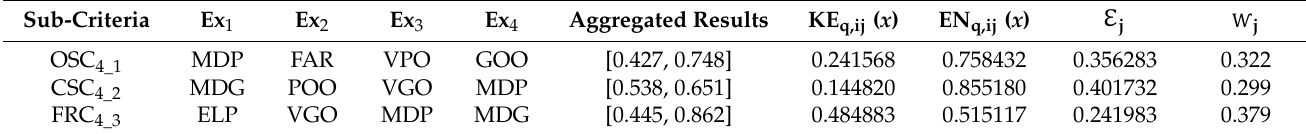
Table 9. Verbal evaluations of the types’ criteria and aggregated main criteria weights.